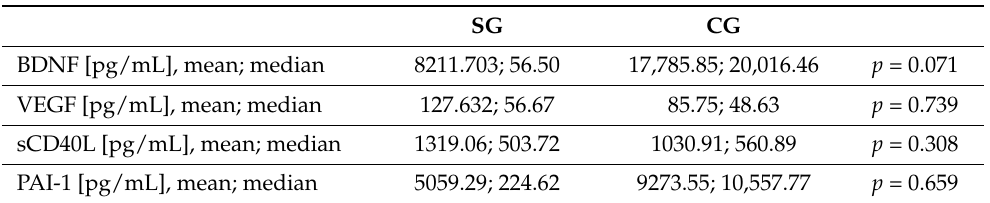
Table 3. Mean values of selected biomarkers of vascular changes in the study group (SG) and the control group